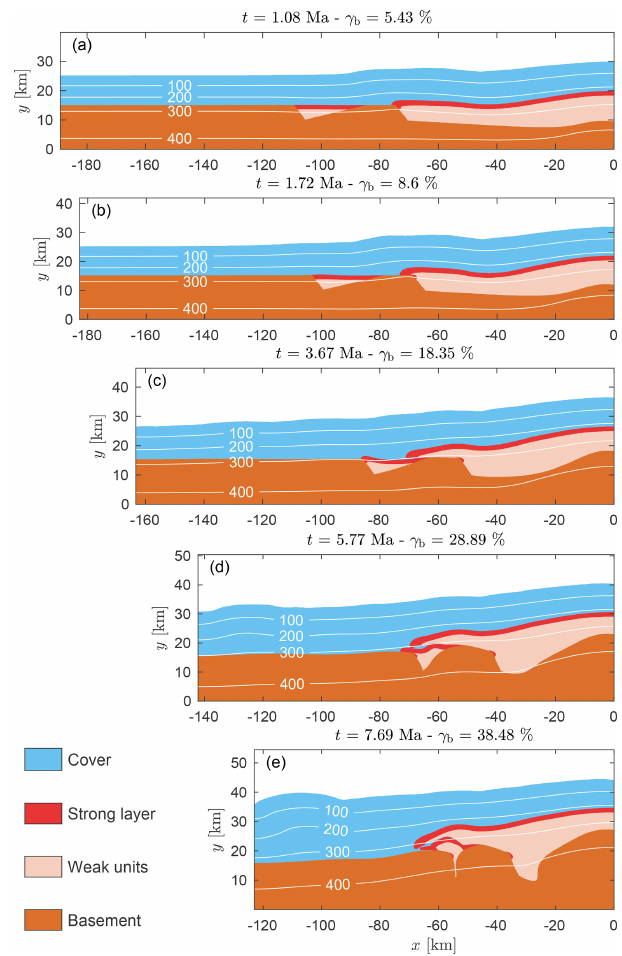
Figure 3. Structural and thermal evolution of the reference model for different times, t , and bulk shortening, γ b . The white contours show isotherms and the labels are the corresponding temperatures in ◦ C. An animation, showing the full time evolution of the reference model, can be found in the